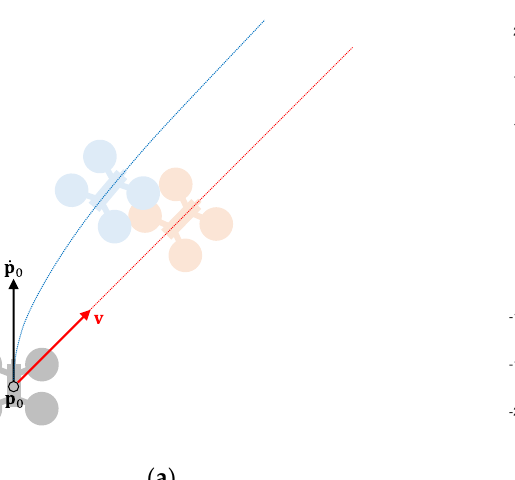
Figure 1. UAV dynamic model. ( a ) Example of a UAV turning 45° clockwise: the red line shows the ideal trajectory fol- lowed if the commanded velocity is applied instantaneously ( |𝐩(cid:4662) 𝟎 | = |𝐯| = 10 𝑚/𝑠 ); the blue line shows its dynamic trajec- tory assuming 𝜏 = 0.5 𝑠 . ( b ) Ideal and real position (every second) of the UAV when turning 45°, 90°, and 135°, respec- tively.